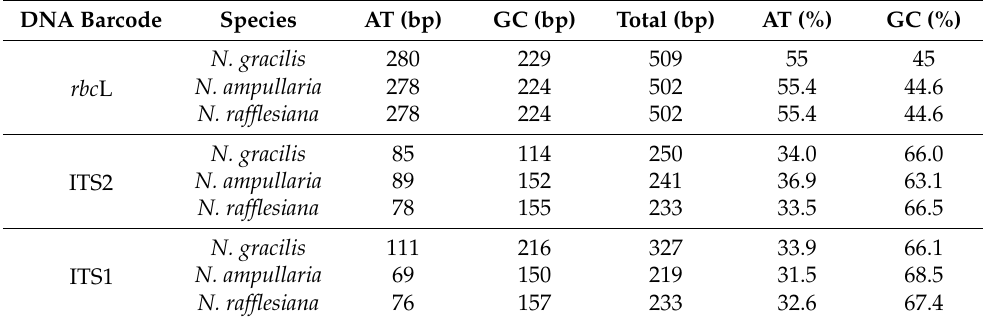
Table 5. The average AT and GC percentage nucleotide composition of N. gracilis, N. ampullaria and N. rafflesiana based on rbc L, ITS2 and ITS1 DNA